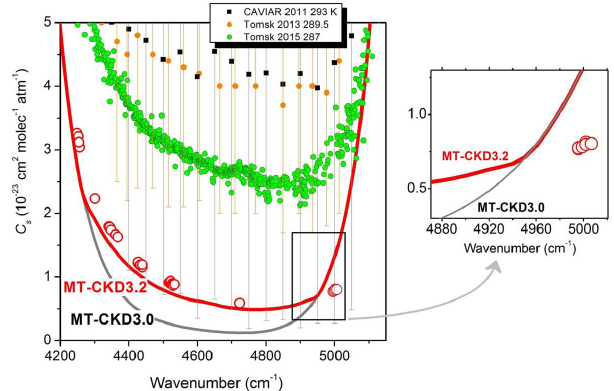
Figure 6. Spectral dependence of self-continuum cross-section at room temperature in the 2.1µm window. The two last versions of the MT_CKD model (V3.0 and V3.2, black and red solid lines, respec- tively) are compared to the cavity-based measurements (red circles), to the FTS results obtained in Tomsk (Ptashnik et al., 2013, 2015; green and orange circles) or by the CAVIAR consortium (Ptash- nik et al., 2011a; black squares). The 30–50% error bars on the Tomsk2015 FTS values and the small error bars on our laser based values are not plotted, for clarity. The zoom highlights the present CRDS values near 5000cm − 1